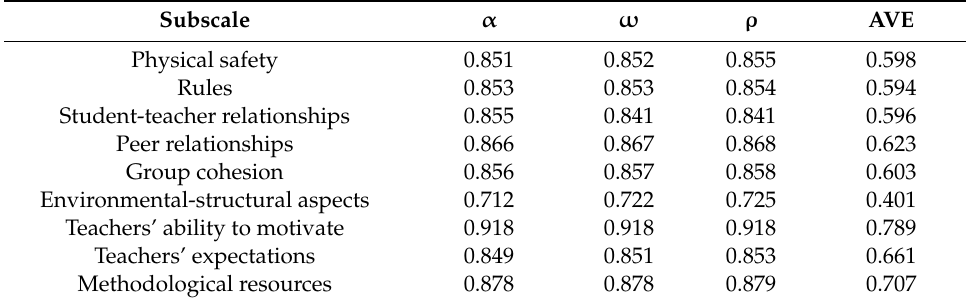
Table 4. Reliability coe ffi cients and average variance extracted (AVE) of the PACE-33 subscales. Subscale α ω ρ